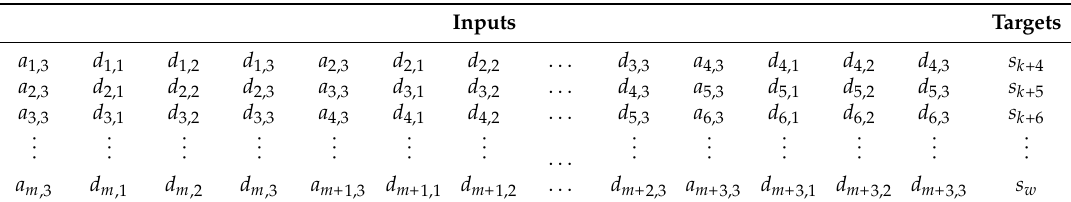
Table 2. BM structure for models WTANNLM and